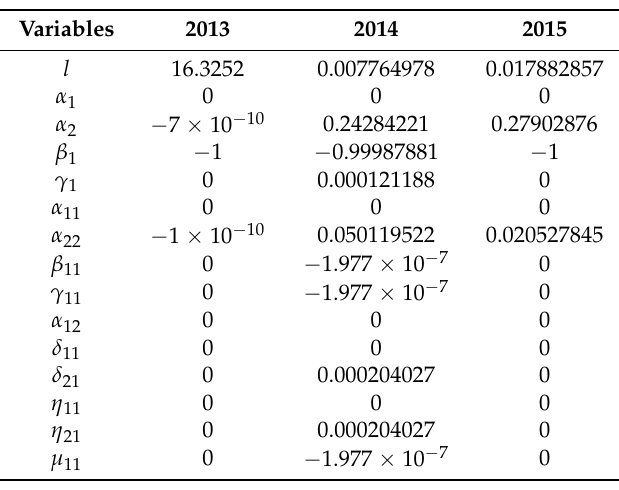
Table 2. Coefficients of Equation (16) per